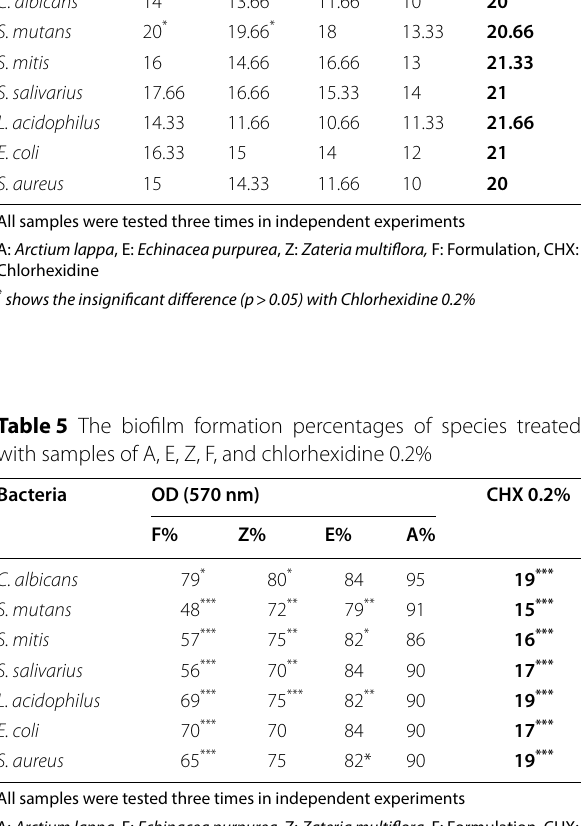
All samples were tested three times in independent experiments